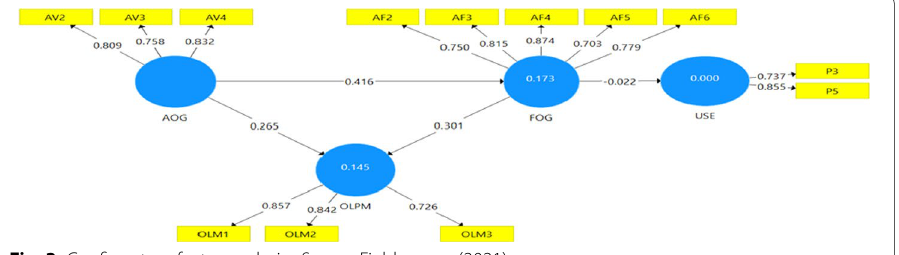
Fig. 3 Confirmatory factor analysis. Source : Field survey